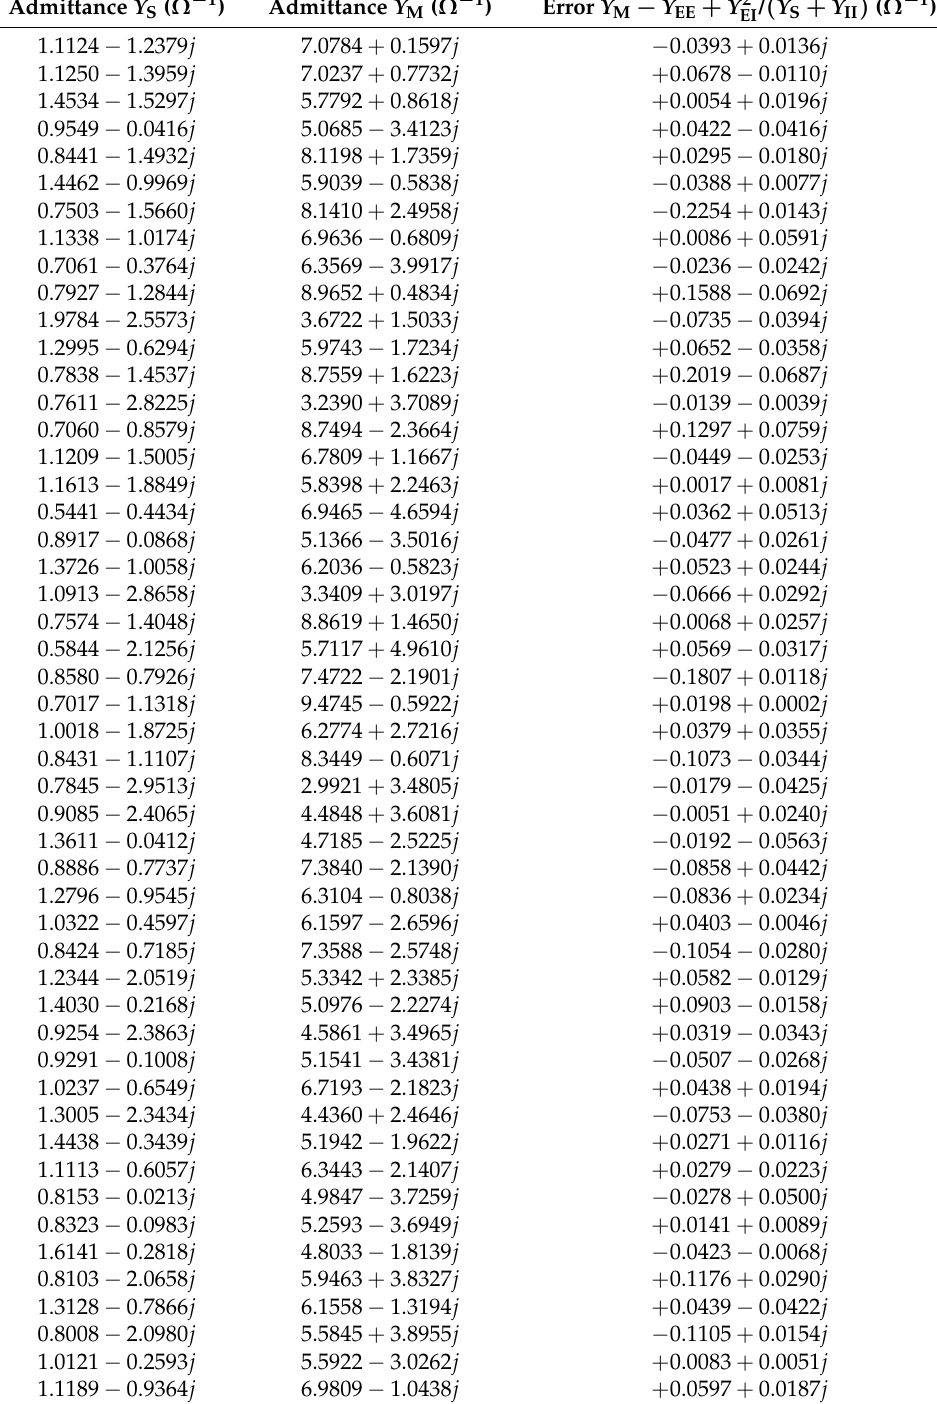
Table 1. Dataset used in the simulation and estimation error between the actual values of the equivalent admittances Y M and their estimations obtained from the estimated two-port model admittance parameters. The standards’ values were generated to simulate resistive-capacitive